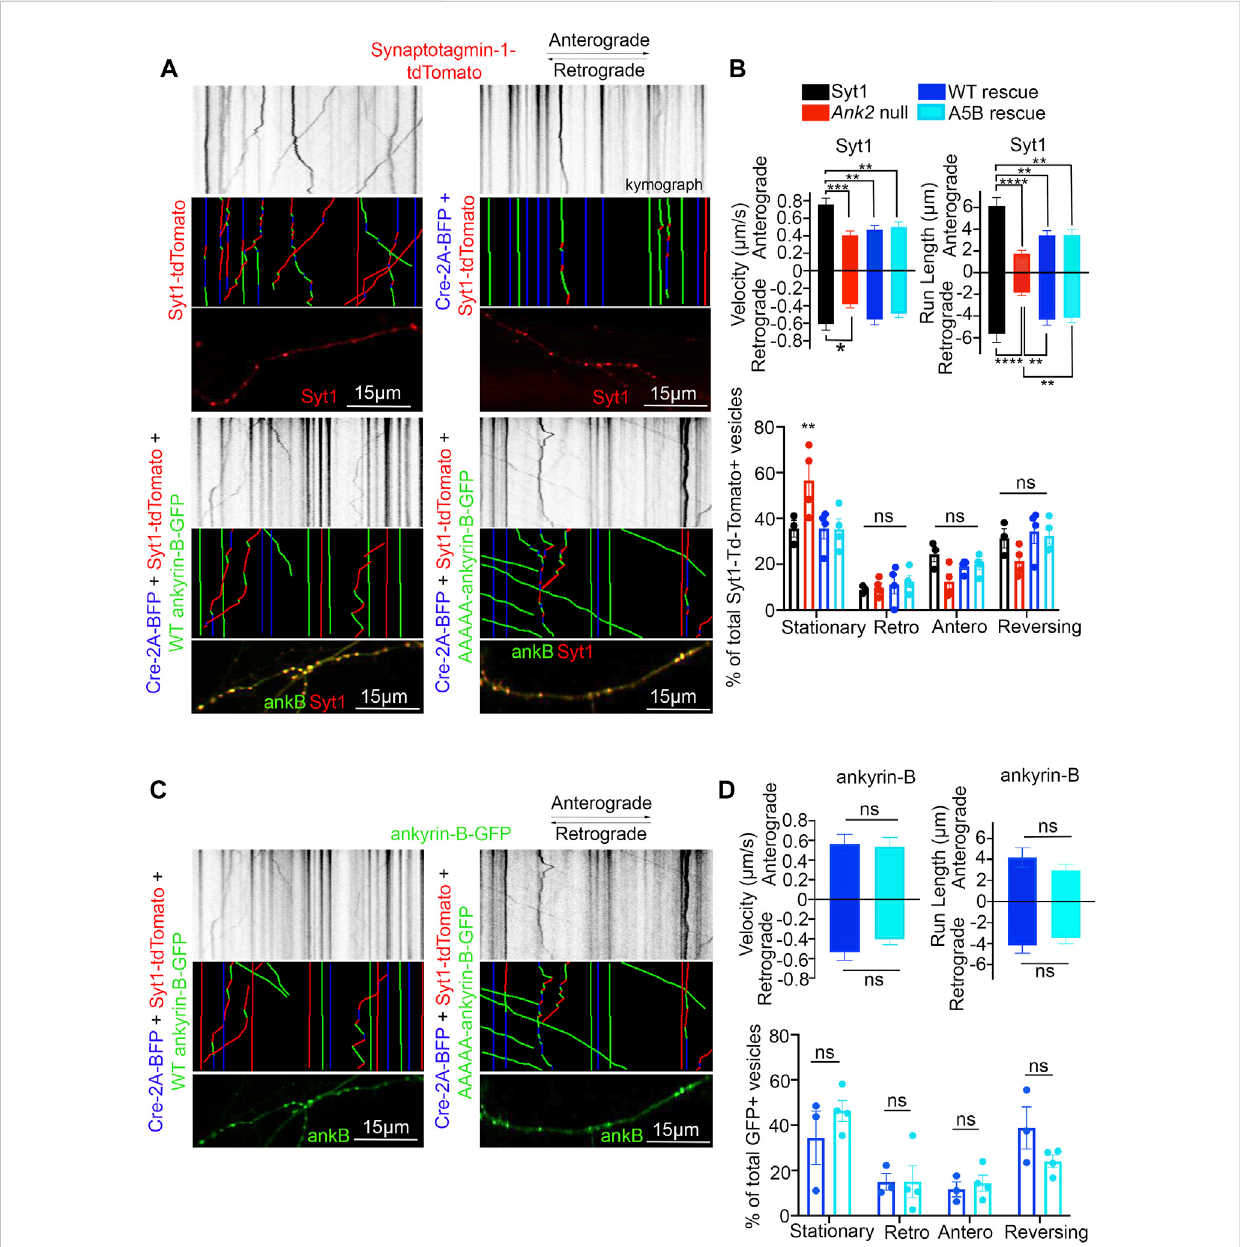
FIGURE 5 Loss of ankyrin-B palmitoylation does not affect axonal cargo transport of synaptic vesicle protein Synaptotagmin-1 (Syt1). (A) (Top) Representative kymographs oftdTomato-taggedSyt1particlemovementalongDIV4axonsof fl oxed Ank2 hippocampalneuronsintheabsence orpresenceofCre-2A- BFPtoknock-outankyrin-BandWTorpalmitoylation-deadAAAAA-ankyrin-B-GFPasrescueplasmids.(Middle)Correspondingcolor-codedtrajectories for tdTomato-positive particles demonstrating static vesicles (blue), anterograde-moving particles (green), and retrograde-moving particles (red). (Bottom)PunctadistributionofSyt1-tdTomatovesiclesalongaxons(regionofaxonusedtogeneratekymographs). (B) .Axonalvelocityandrunlengthfor Syt1 particles. Data shown is from one representative experiment out of 4 independent repeats. N = four to eight axons per condition (n = 88 – 154 particles per condition). Data represent means ± SEM. ** p < 0.01, *** p < 0.001, **** p < 0.0001. For velocity and run lengths analyses, one-way ANOVA with Tukey ’ s post-hoc test were performed. For % motility analysis, two-way ANOVA with multiple comparisons and Tukey ’ s post-hoc was performed. (C) .(Top)Representativekymographs ofGFP-taggedankyrin-BparticlemovementalongDIV4axonsof fl oxed Ank2 hippocampalneuronsin the absence or presence of Cre-2A-BFP to knock-out ankyrin-B and WT or palmitoylation-dead AAAAA-ankyrin-B-GFP as rescue plasmids. (Middle) Corresponding color-coded trajectories for GFP-positive particles demonstrating static vesicles (blue), anterograde-moving particles (green), and retrograde-moving particles (red). (Bottom) Puncta distribution of WT or AAAAA-ankyrin-B-GFP vesicles along axons (region of axon used to generate kymographs). (D) .Axonalvelocityandrunlengthforankyrin-Bparticles.Datashownisfromonerepresentativeexperimentoutof4independentrepeats. N = 3-7 axons per condition (n = 38 – 76 particles per condition). Data represent means ± SEM. not signi fi cant (ns). For velocity and run lengths analyses, Student ’ s t-test s were performed. For % motility analysis, two-way ANOVA with multiple comparisons and Tukey ’ s post-hoc was